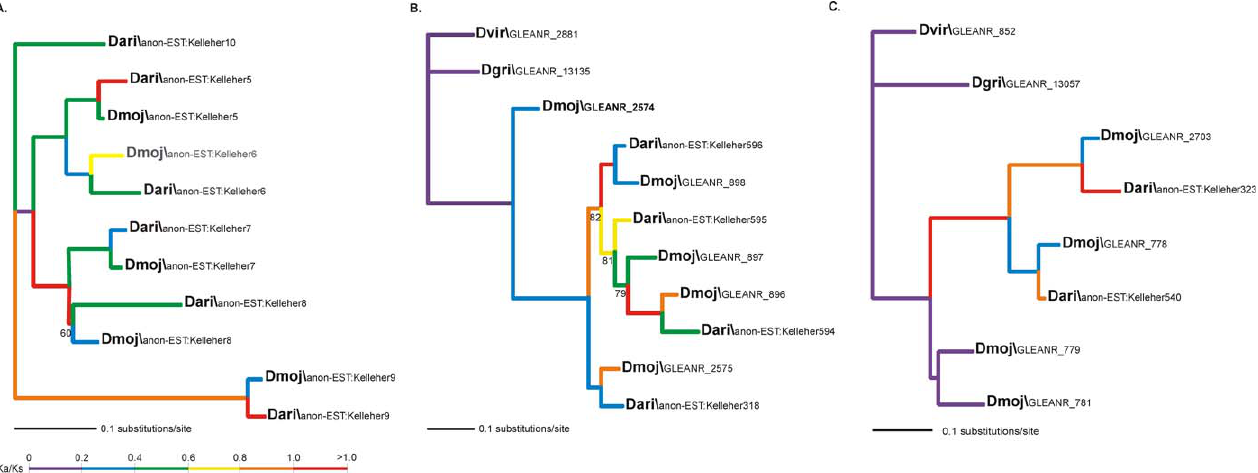
Figure 3. Bayesian Phylogenies of (A) Protease Gene Family 1, (B) Protease Gene Family 2, and (C) Protease Gene Family 3 (A) is midpoint rooted, as D. virilis sequence was too divergent to make an appropriate outgroup. Grey taxon name denotes a pseudogene. Branch colors indicate Ka/Ks values calculated in the codeml package of PAML [47]. Posterior probabilities , 90 are noted.